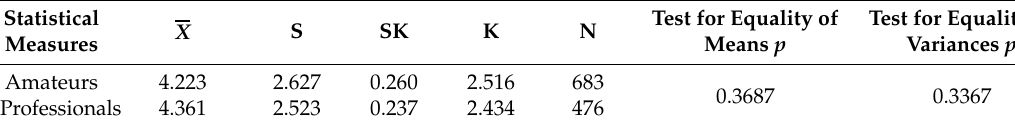
Figure 8. Relatively high prices of services at sports and recreation facilities, in the opinion of service recipients (professional athletes). Source: own work. Table 9. Statistical characteristics of a sports and recreation facility for competitive sport purposes, in the opinion of service recipients.